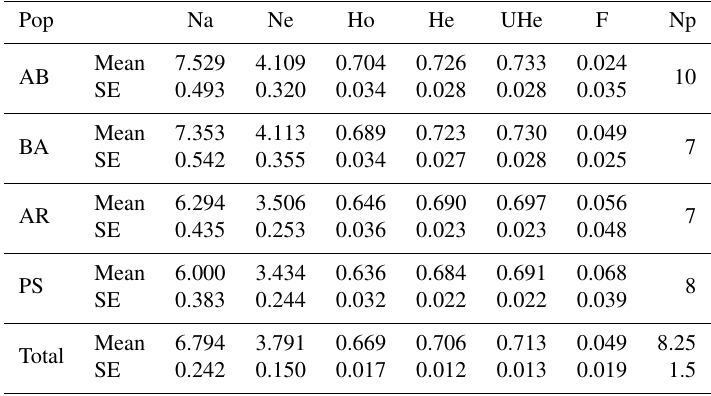
Table 2. Allelic frequency and heterozygosity for analyzed Tunisian breeds. Pop Na Ne Ho He UHe F Np Mean AB